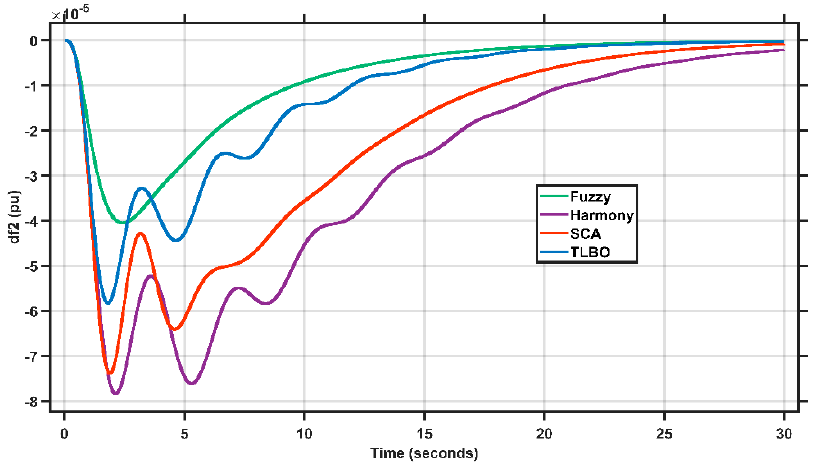
Figure 19. Change in area 2 frequency under 1% load change in area 1.